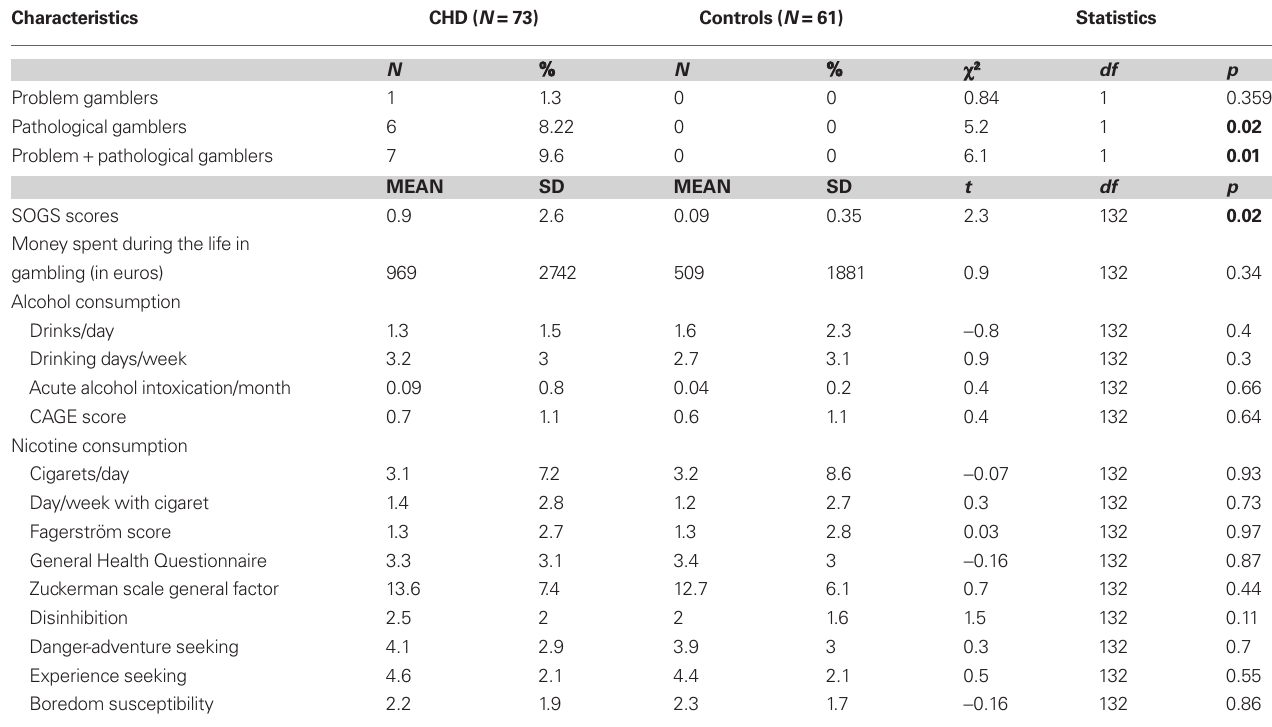
Table 1 | Pathological and problem gambling among patients hospitalized in cardiology for a coronary heart disease (CHD).